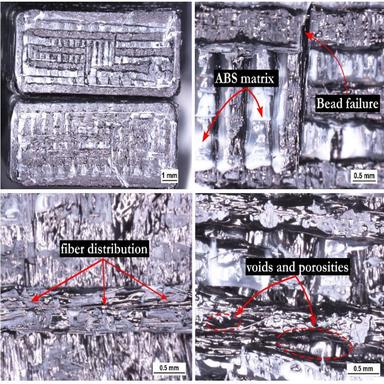
Micrography of FGM specimen fabricated and tested on XZ plane.